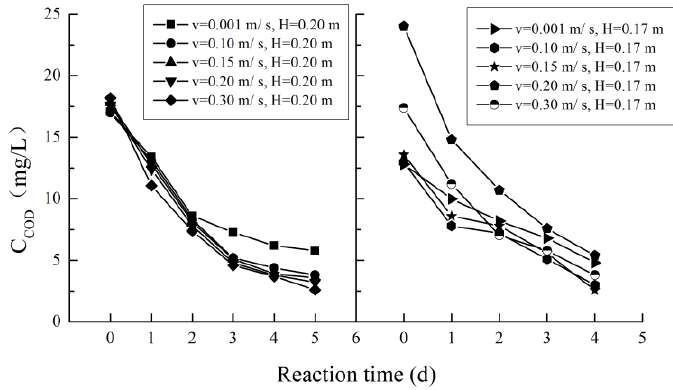
Figure 3. Variation in the chemical oxygen demand (COD) concentration under different hydraulic conditions.